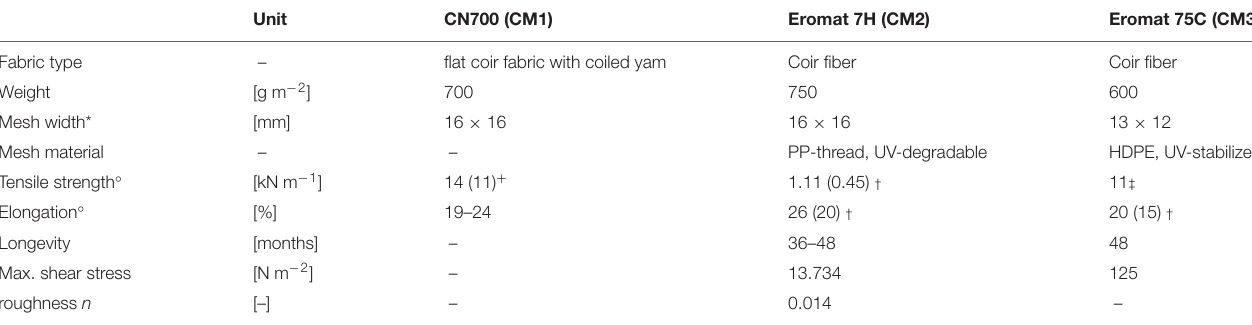
TABLE 2 | Technical specifications of the coir mats used for the experiments.